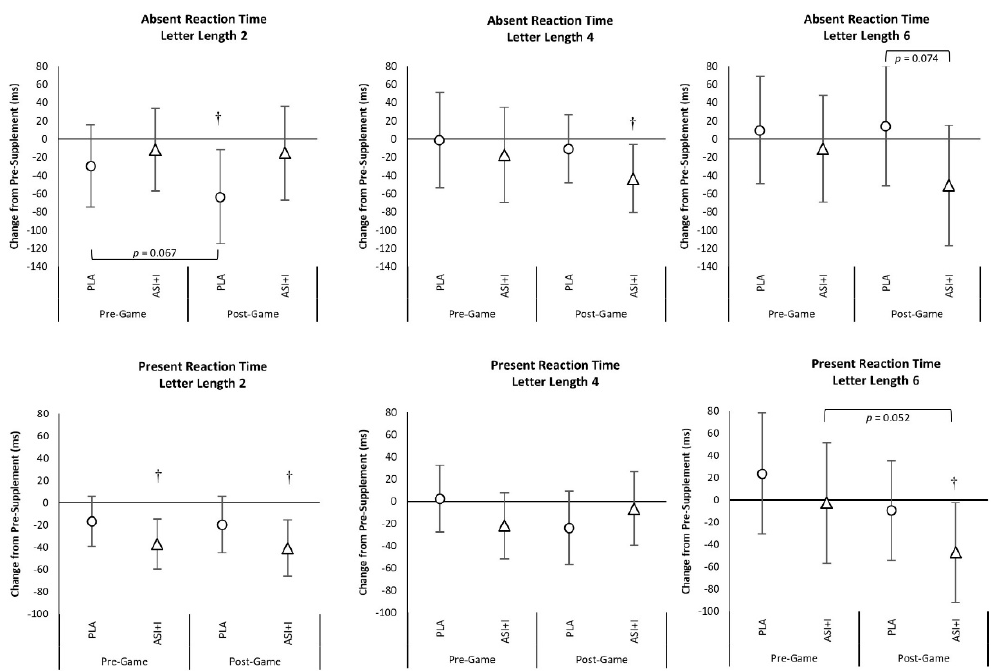
Figure 4. Mean changes with 95% Confidence Intervals in Absent and Present Reaction Times. † represents p < 0.05 difference from baseline.